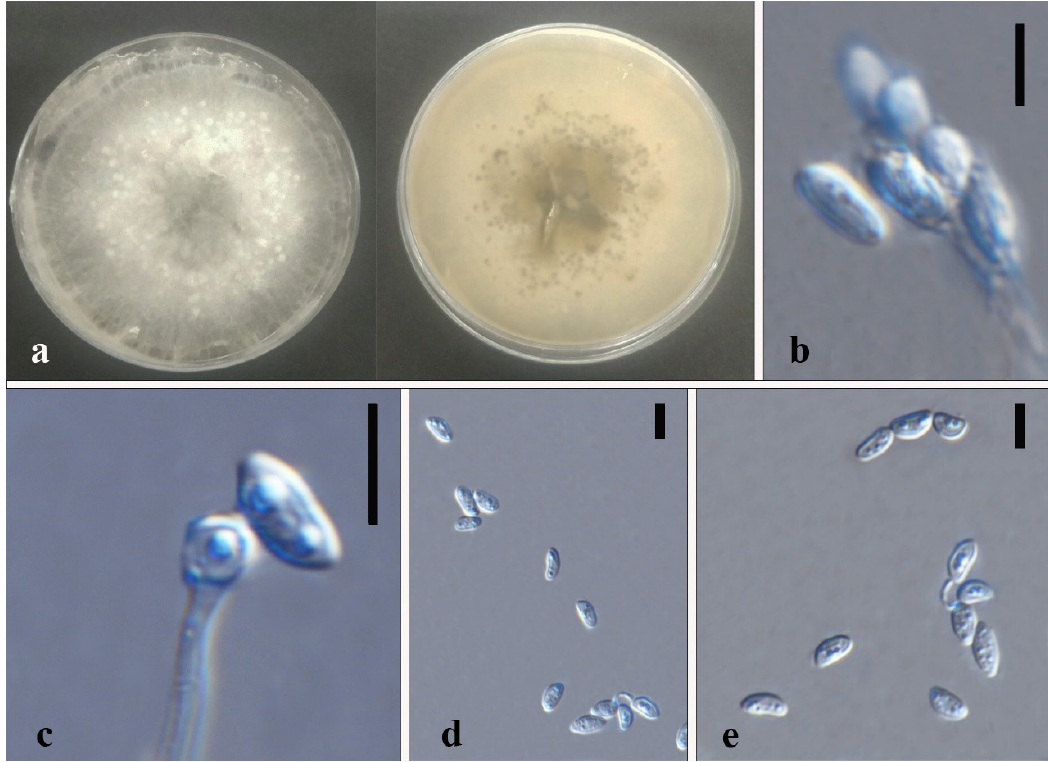
Figure 16. Xylaria sp. 3 (MFLU XX). ( a ) Colony on 4% OA (MFLUCC 21-0059) (left-front view, right-reverse view). ( b , c ) Conidia with conidiophores. ( d , e ) Conidia. Notes: ( b – e ) on 4% OA. Scale bars: ( b – e ) = 5 μ m.